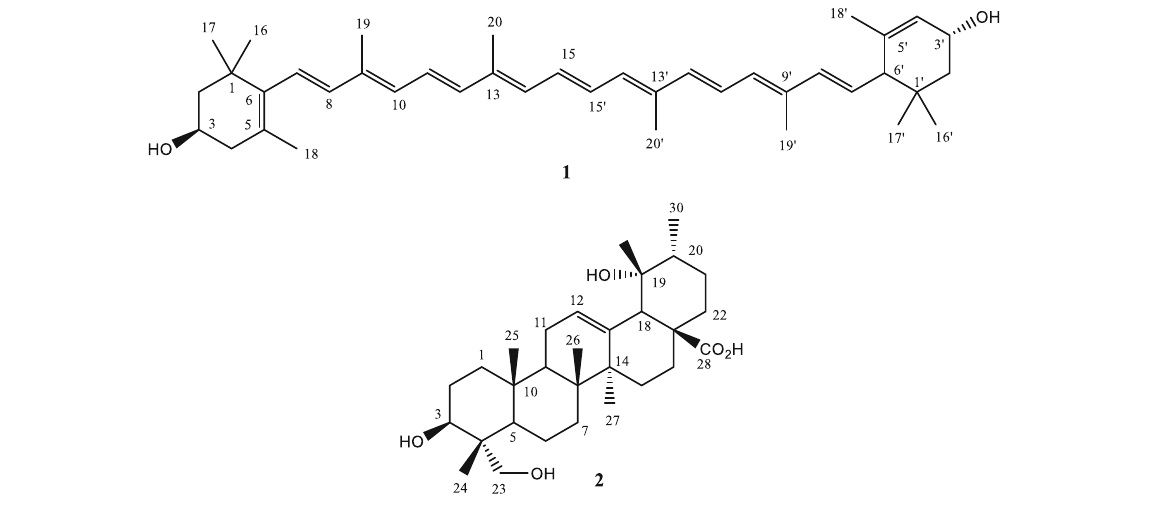
Fig. 2 Chemical structures of lutein (1) and rotundic acid (2) isolated from O. speciosus